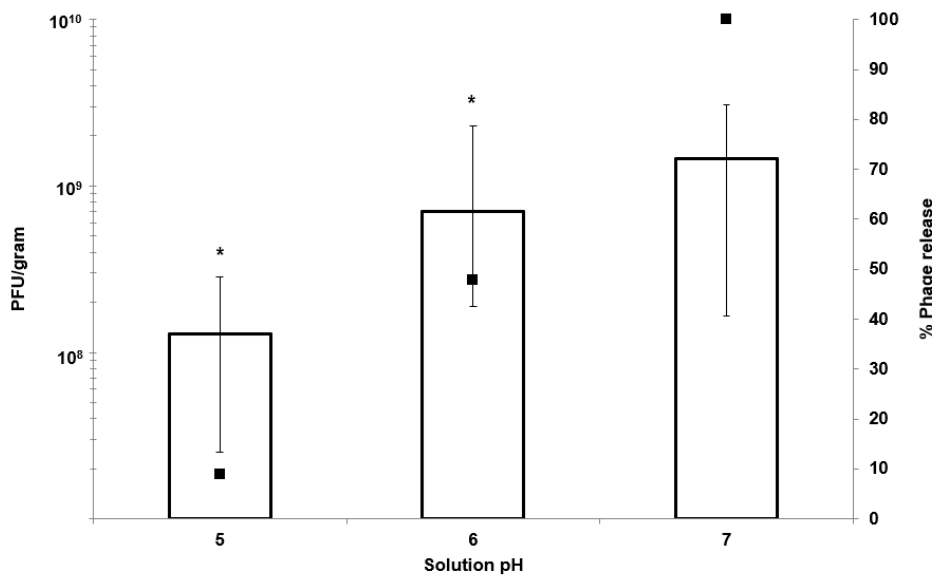
Figure 6. Release of encapsulated bacteriophages from EK1F microparticles: Phage release (PFU g − 1 ) after 5 h from EK1F microparticles in Simulated Intestinal Fluid (SIF) at different pH values following prior exposure of microparticles to Simulated Gastric Fluid (SGF) at pH 2 (2 h exposure to SGF). The black squares represent the % phage release. *Significantly different phage titres ( p < 0.05) for a 2-sample t -test with each sample compared with phage release from EK1F exposed to pH 7.